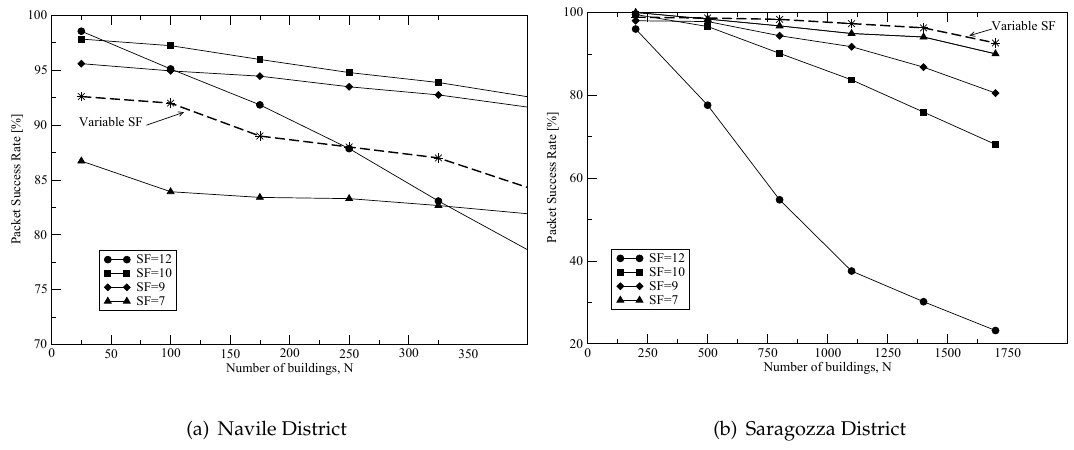
Figure 8. Packet success rates vs. number of buildings in both the Navile and Saragozza